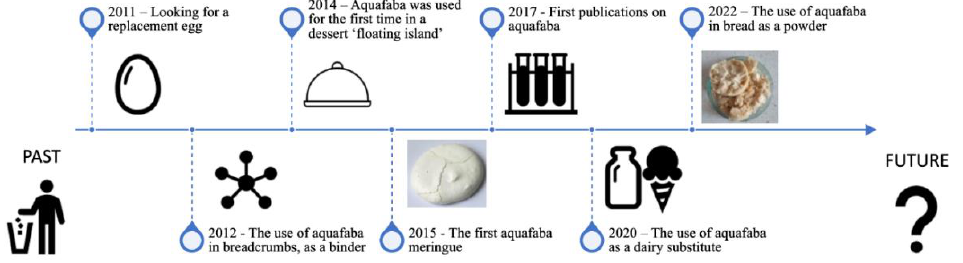
Figure 1. A simplified history of aquafaba.